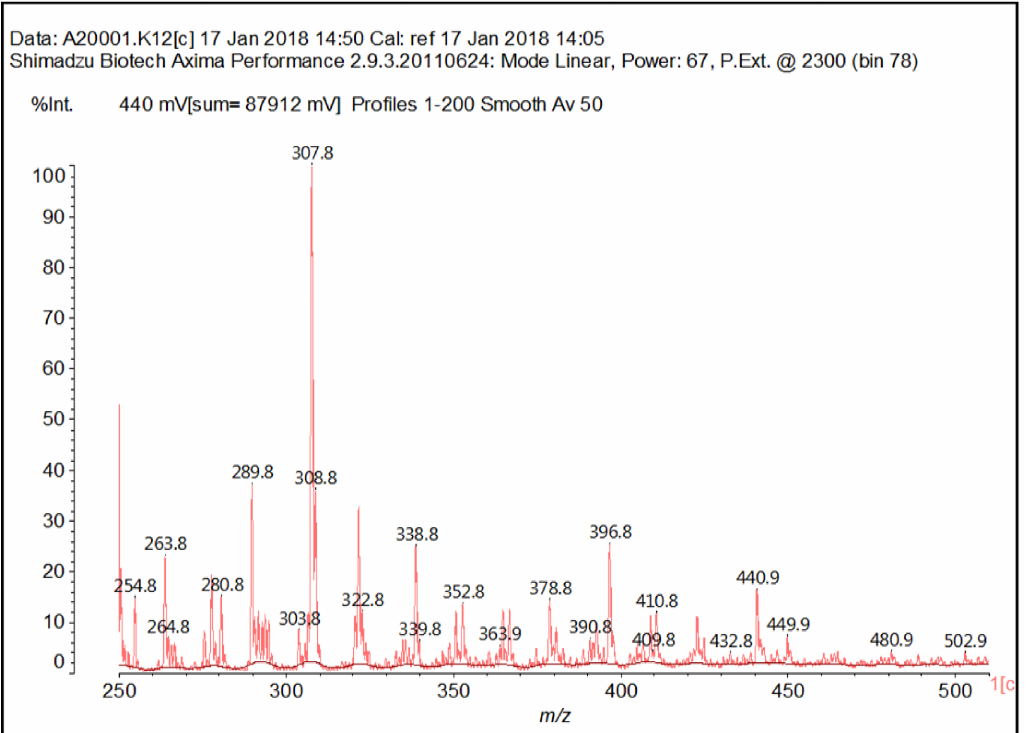
Figure 9. MALDI ToF spectrum of the A2 NIPU. Detail of the 250–500 Da